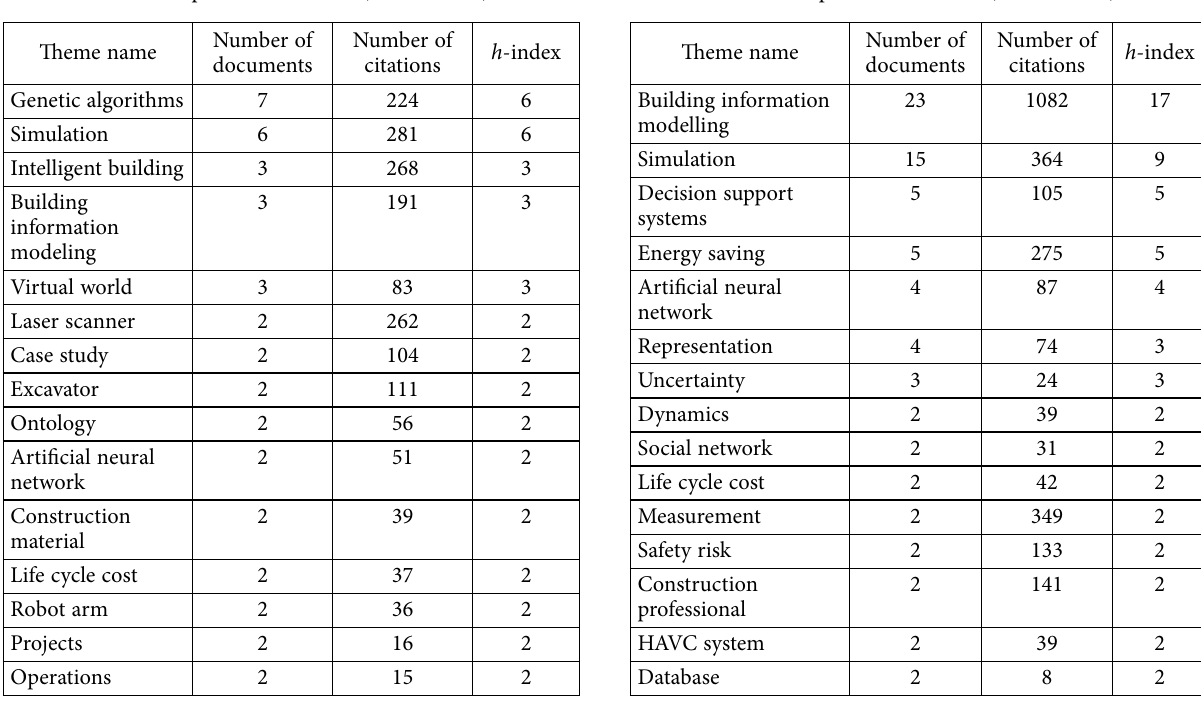
Figure 7. The strategic diagram of the sub-period 2005–2009 Table 8. Performance measures of themes Table 9. Performance measures of